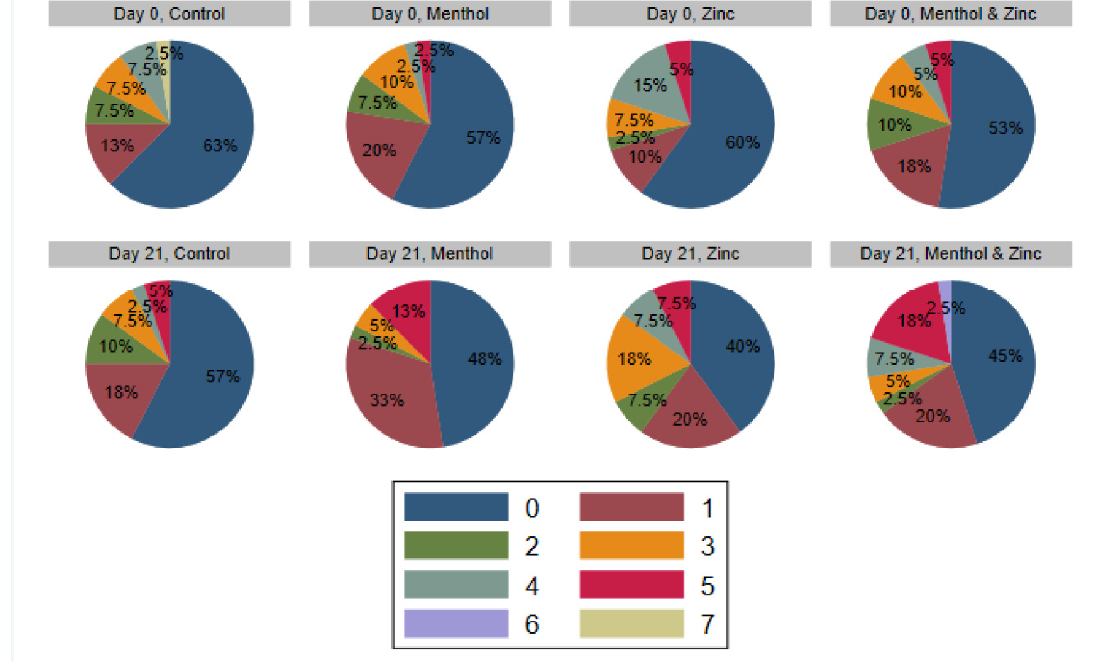
Figure 6. Resistance (%) of E. coli isolates to number of antibiotic classes by sample day and treatment. Each color indicates the specified corresponding number of antibiotic classes to which antibiotic resistance was observed.